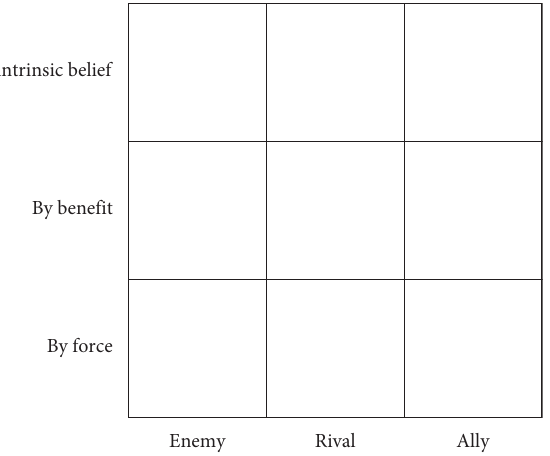
Figure 1: Te cultures of anarchy ([20],